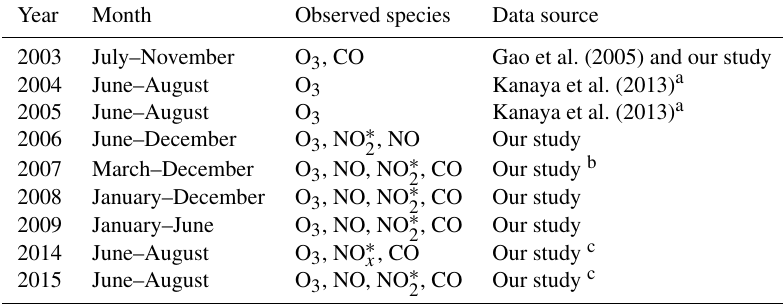
Figure 1. Geographical map showing the North China Plain and the location of Mt. Tai. The left map is color-coded by the HCHO column density in the summer period (JJA; 2003–2014) retrieved from SCIAMACHY and GOME-2(B). Table 1. The observations at Mt. Tai analyzed in the present